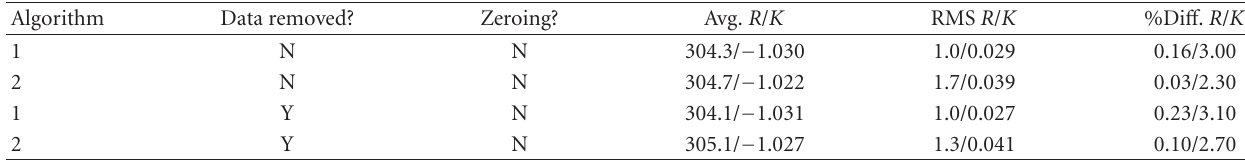
Table 2: Results of measurement using di ff erent starting values for R and K